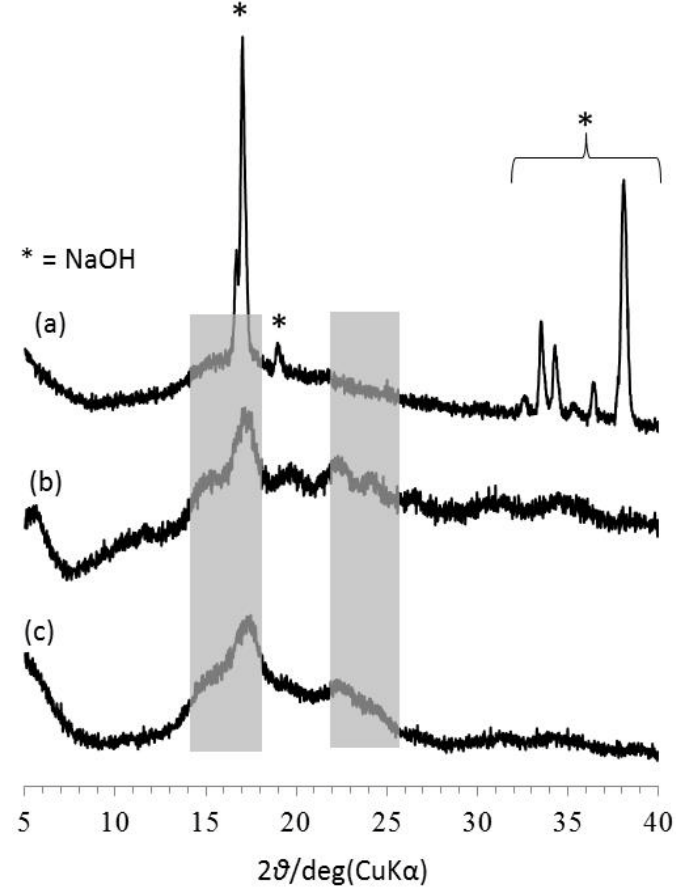
Figure 3. XRD profiles of films of 3 from cotton ( a ) before and ( b ) after washing out the alkali and ( c )